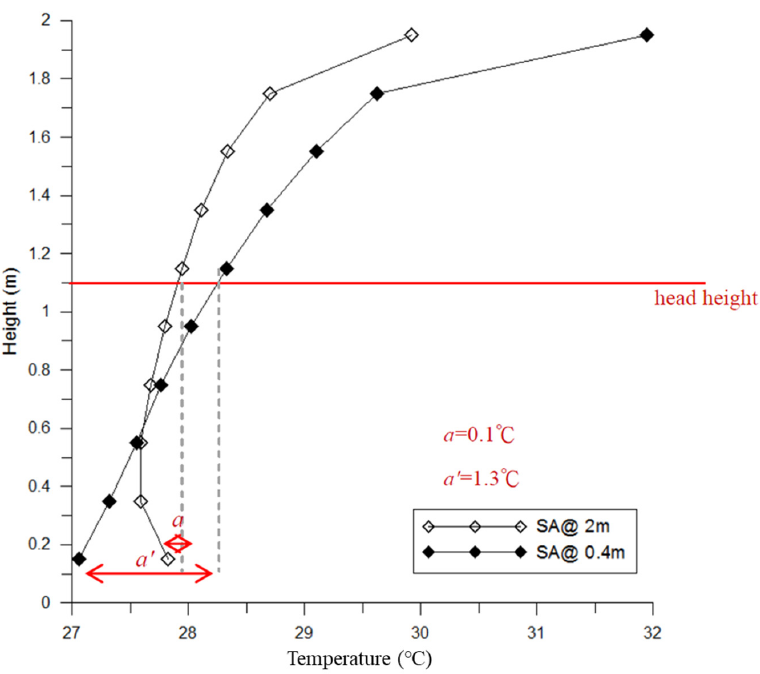
Figure 17. Vertical temperature distribution of public area with varying SA height.